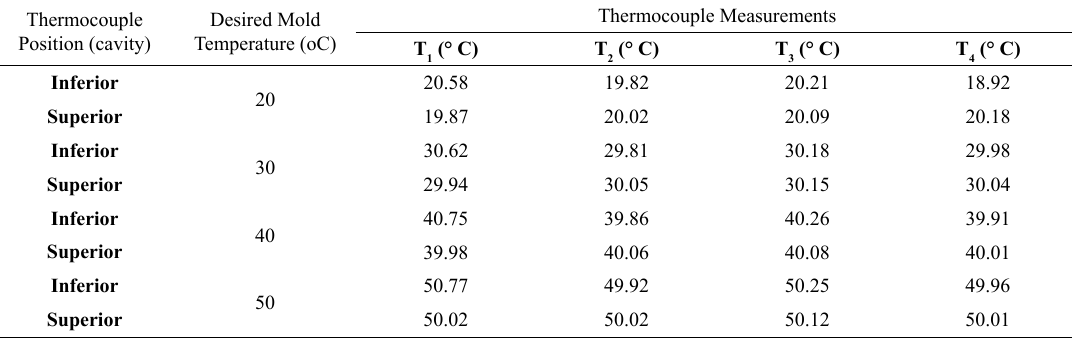
Table 3. Temperature measured by the thermocouples for each mold temperature considered in the tests. Thermocouple Position